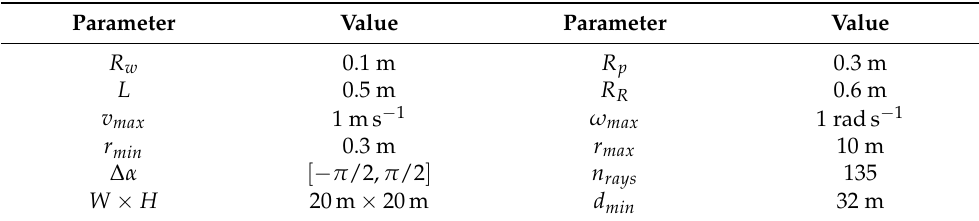
Table 1. Summary of the parameters describing the whole environment simulation, including the robot, pedestrians, and range sensor.